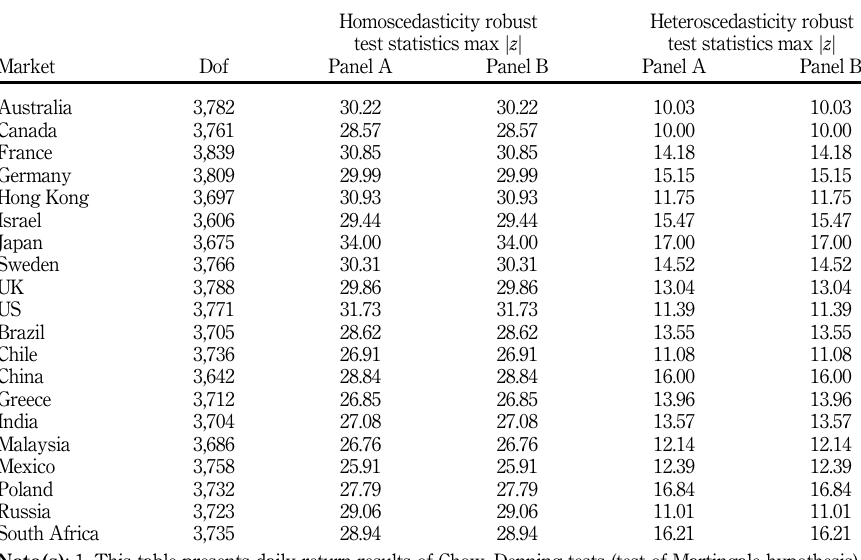
variance ratio test results based on